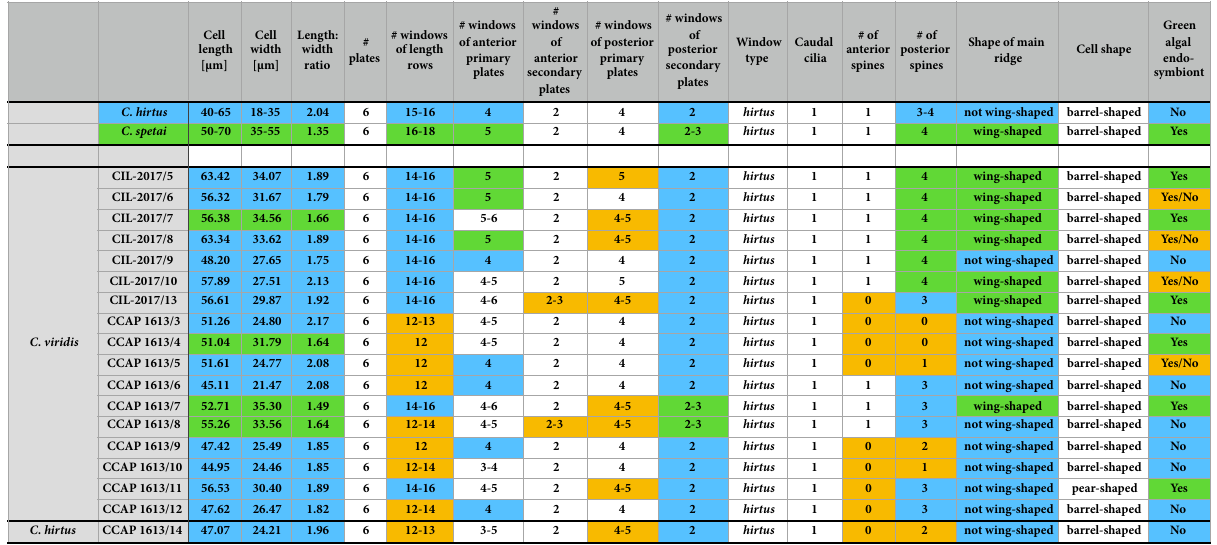
Table 1. Morphological features of the investigated strains compared to those of Coleps hirtus (color-coded in blue) and C. spetai (colour-coded in green) according to Foissner 22 . Constant and divergent features are marked in white and orange,